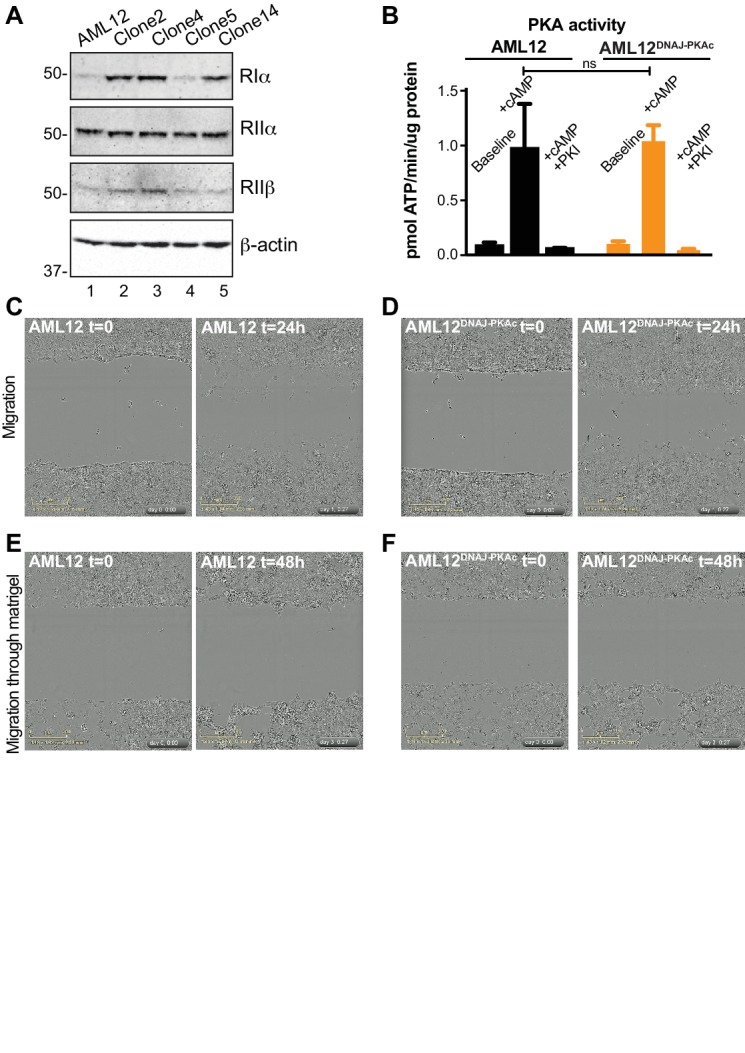
Additional characterization of AML12DNAJ-PKAc cells.(A) Immunoblot detection of PKA RIα (top panel), RIIα (mid-top panel) and RIIβ (mid-lower panel) subunits in parental AML12 cells and four clonal AML12DNAJ-PKAc cell lines. Bottom) Actin loading control. (B) The specific activity (pmol/μg/min) of basal and cAMP responsive PKA activity in wildtype AML12 (black) and clone 14 AML12DNAJ-PKAc (orange) was measured by radioactive kinase assay using Kemptide as a substrate. PKI 5–24 inhibitor peptide specifically blocked PKA activity. Representative data (mean ±s.d.) from three independent experiments. Holm-Sidak T-tests were performed. (C–F) Motile properties of AML12DNAJ-PKAc cells as measured by scratch wound. Migration of (C) AML12 and (D) clone 14 AML12DNAJ-PKAc cells. Images were collected every 45 min over 24 hr of n > 3 replicates. Time 0 (t = 0) is immediately after scratch-wounding. Transmigration through matrigel of (E) AML12 and (F) AML12DNAJ-PKAc cells. Images were taken every 45 min for 48 hr of n > 3 replicates; representative data shown. Time 0 (t = 0) is immediately after scratch-wounding. Scale bar is 300 μm.